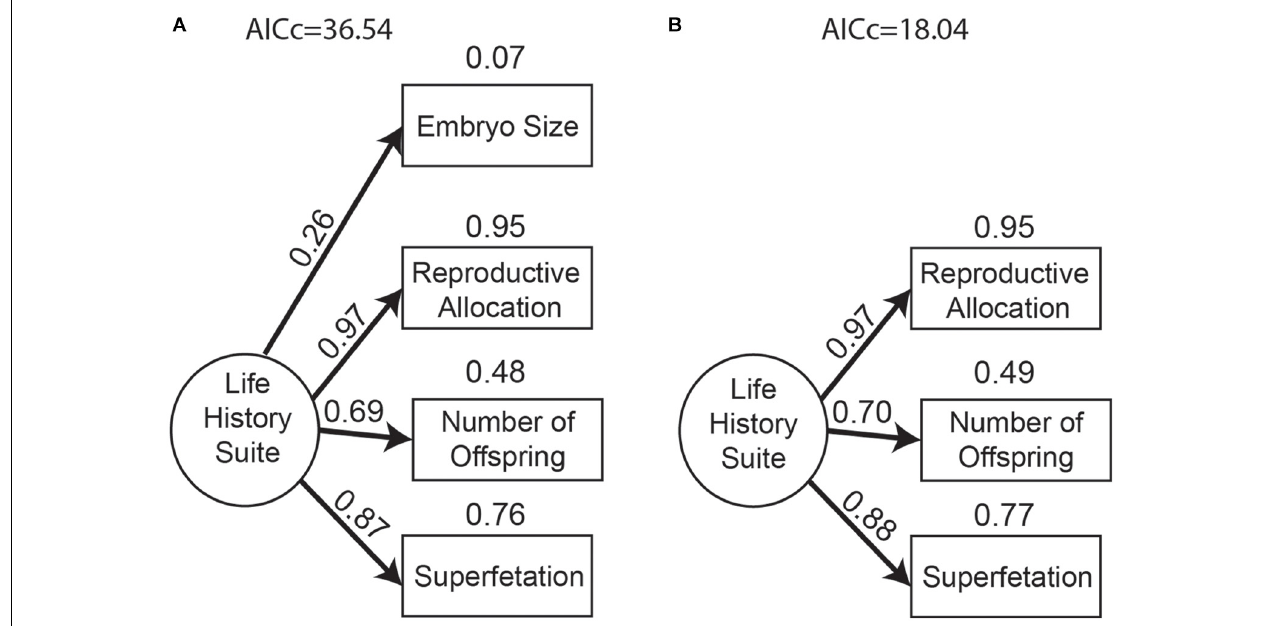
FIGURE 3 | Path diagrams of confirmatory factor analysis for (A) all life-history traits as a single measure and (B) excluding embryo size. Path diagram shows loadings above each path and proportion of variance accounted for ( R 2 ) above each life-history trait.